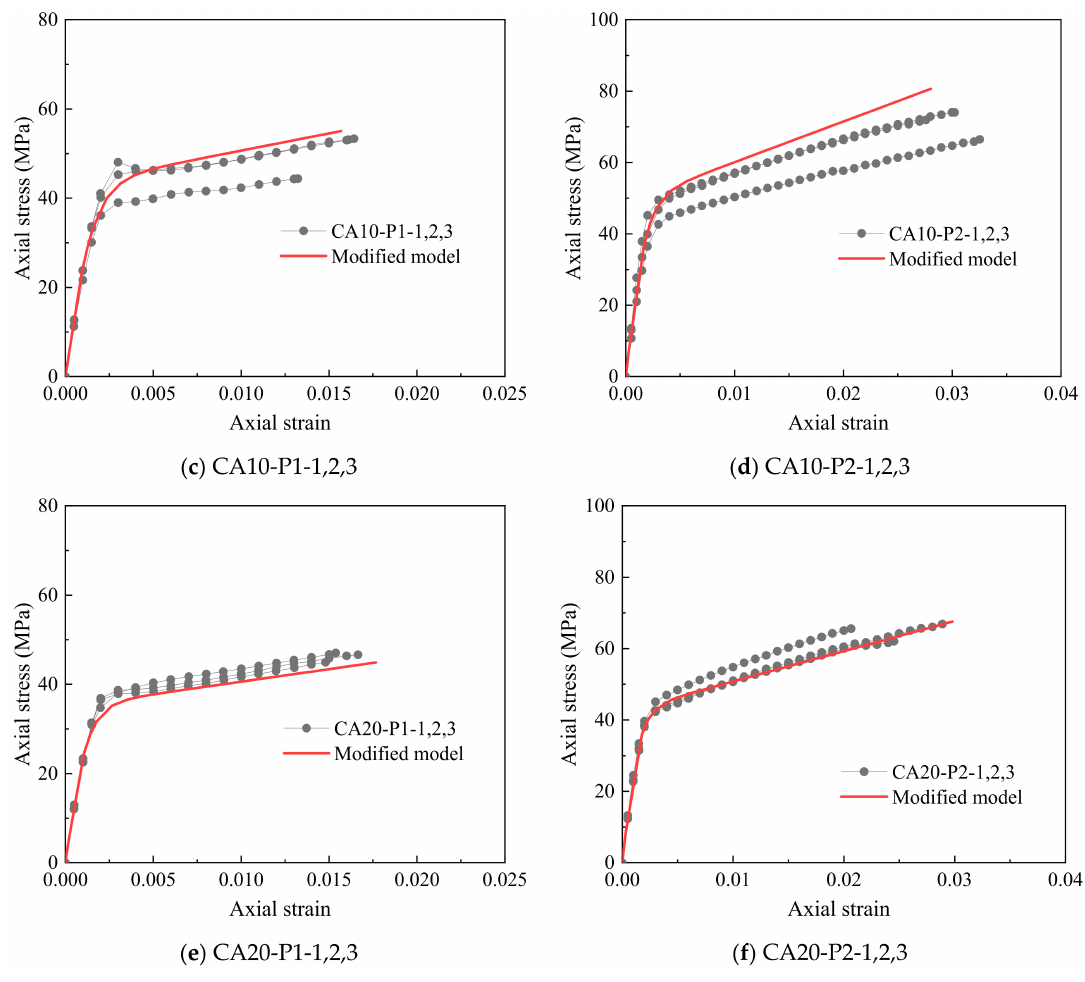
Figure 14. Performance of the modified